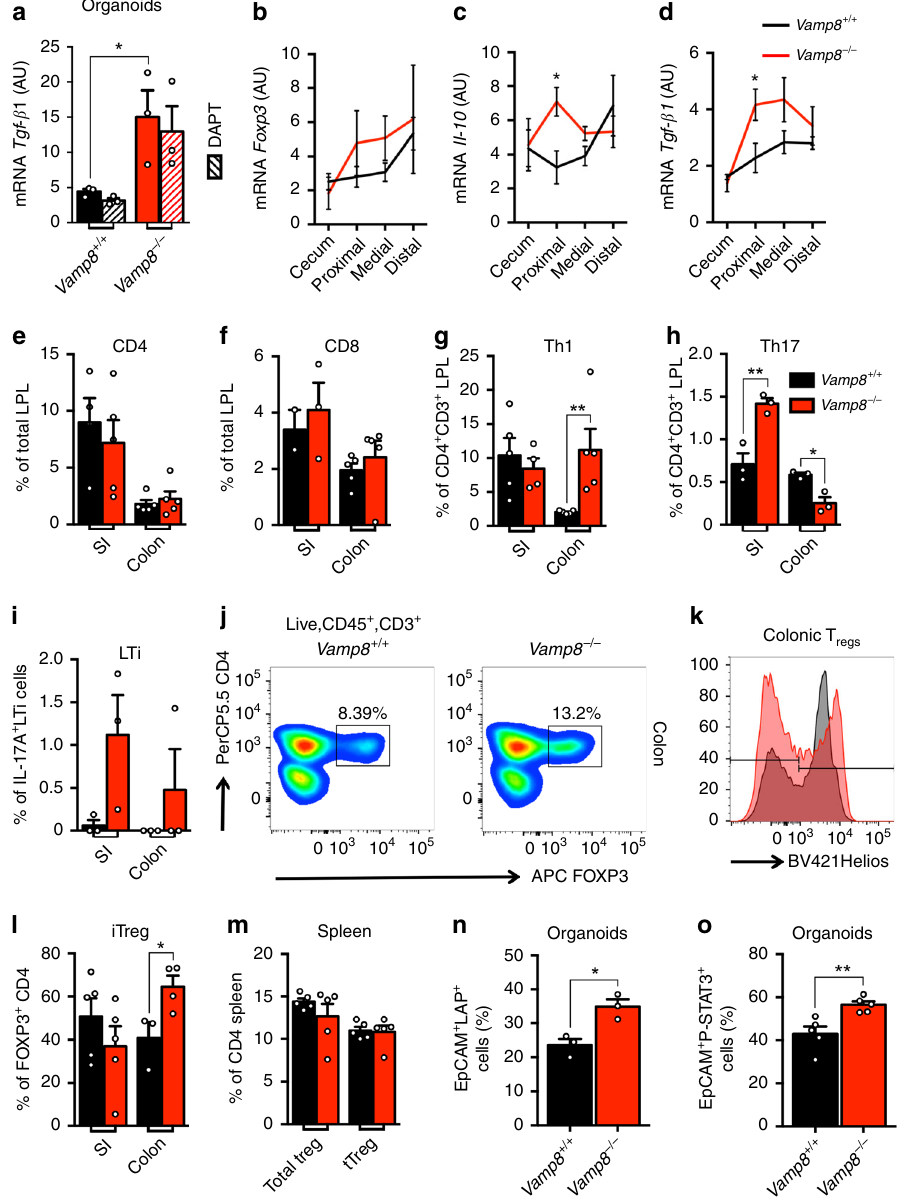
Fig. 5 Barrier defects in Vamp8 − / − drives a tolerogenic phenotype. a Colonic organoids derived from Vamp8 + / + and Vamp8 − / − littermates were analyzed for mRNA expression of Tgf- β 1 by qPCR with (hashed bars) and without 5 μ M DAPT for 24 h after 7 days in culture (representative data of one experiment independently repeated two times, three wells/condition). Tolerogenic markers Foxp3 b , Il-10 c , and Tgf- β 1 d assessed by qPCR were assayed by qPCR to determine mRNA expression (representative data of one experiment independently repeated three times with more than three mice per group). T cell pro fi ling was performed on lamina propria lymphocytes (LPL) isolated from Vamp8 + / + and Vamp8 − / − littermates and total abundance of CD4 e and CD8 f T cells assessed (representative data of one experiment independently repeated two times with fi ve mice per group). Abundance of Th effector CD4 T cells including Th1 ( g ; LiveCD45 + CD3 + CD4 + Ifn γ + ) and Th17 ( h ; LiveCD45 + CD3 + CD4 + Il17A + ), as well as LTi cells ( i ; LiveCD45 + CD3 − CD4 + Il17A + ) were determined in the small intestine and colonic LPL after activation in vitro with PMA/ Ionomycin with GolgiStop and GolgiPlug for 6 h (representative data of one experiment independently repeated two times with more than three mice per group). j Representative FACS plots of Tregs from colonic LPL. k Colonic Tregs (LiveCD45 + CD3 − CD4 + FOXP3 + ) in Vamp8 − / − (red) and Vamp8 + / + (black) were quanti fi ed to discriminate thymic (Helios + ) vs. periphery (Helios − )-derived Tregs. l Percentage of total Tregs devoid of the thymic marker Helios, thus termed iTregs, in small intestine and colonic LPL (representative data of one experiment independently repeated three times with more than three mice per group). m Spleenic regulatory T cell lineage commitment was assessed in Vamp8 + / + and Vamp8 − / − (representative data of one experiment independently repeated two times with fi ve mice per group). Colonic organoids were cultured and analyzed by fl ow cytometry for expression of Tgf- β 1 (LAP; n ) and Phospho-Stat3 o (representative data of one experiment independently repeated two times, three wells/condition). Bars indicate mean ± standard error of the mean. * P < 0.05, ** P < 0.01 Unpaired two-tailed Student T -test a – i , l –